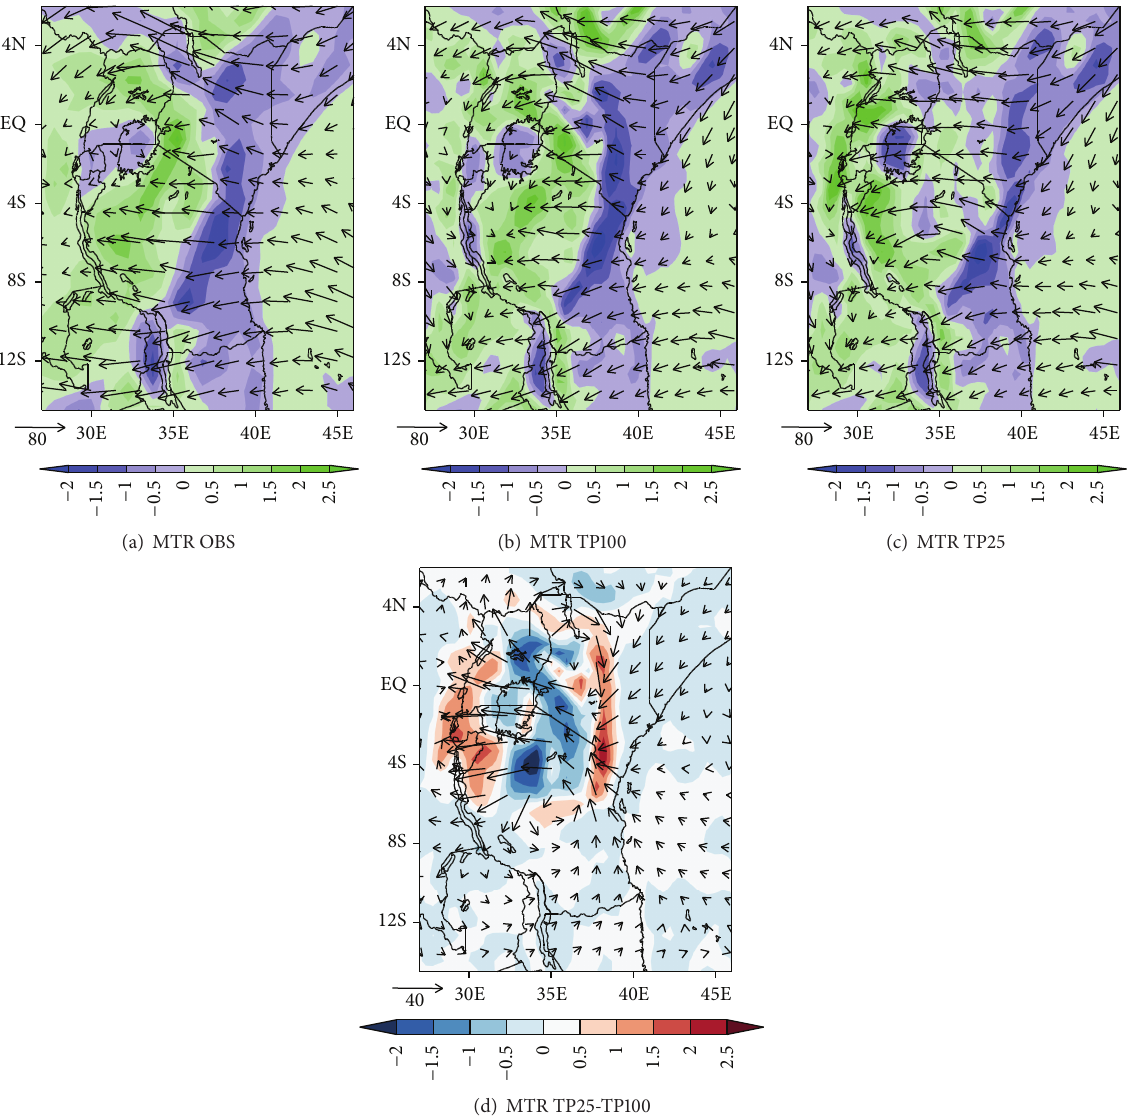
Figure 6: Climatology of OND water vapor/moisture transport (MTR) at 850 hpa in g kg −1 ms −1 over the period 2000–2008. The shaded regions indicate moisture convergence ( positive ) and moisture divergence ( negative ), and the vectors show water vapor transport. (a) ERA interim reanalysis MTR, (b) simulated MTR using actual topography (TP100), (c) simulated MTR when KTU topography is reduced to 25%, and (d) difference in MTR [(c) minus